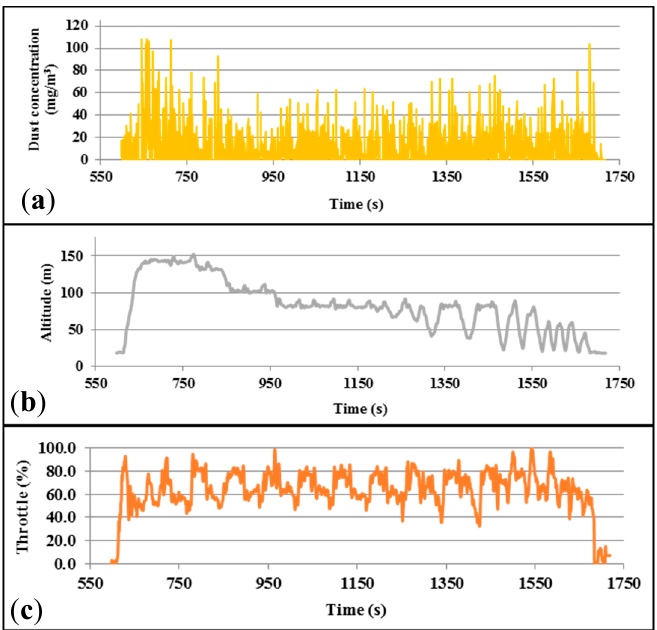
Figure 11. Data collected from Teklite flight with SHARP sensor attached. ( a ) Dust concentration; ( b ) Altitude; ( c ) Throttle.